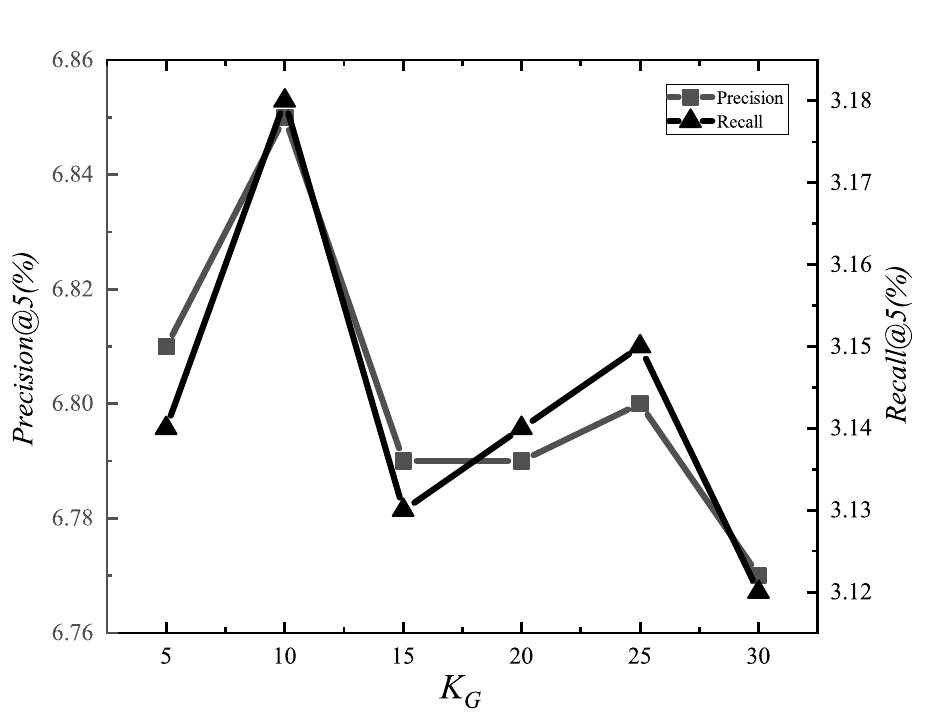
Fig 7. Tuning parameters( K